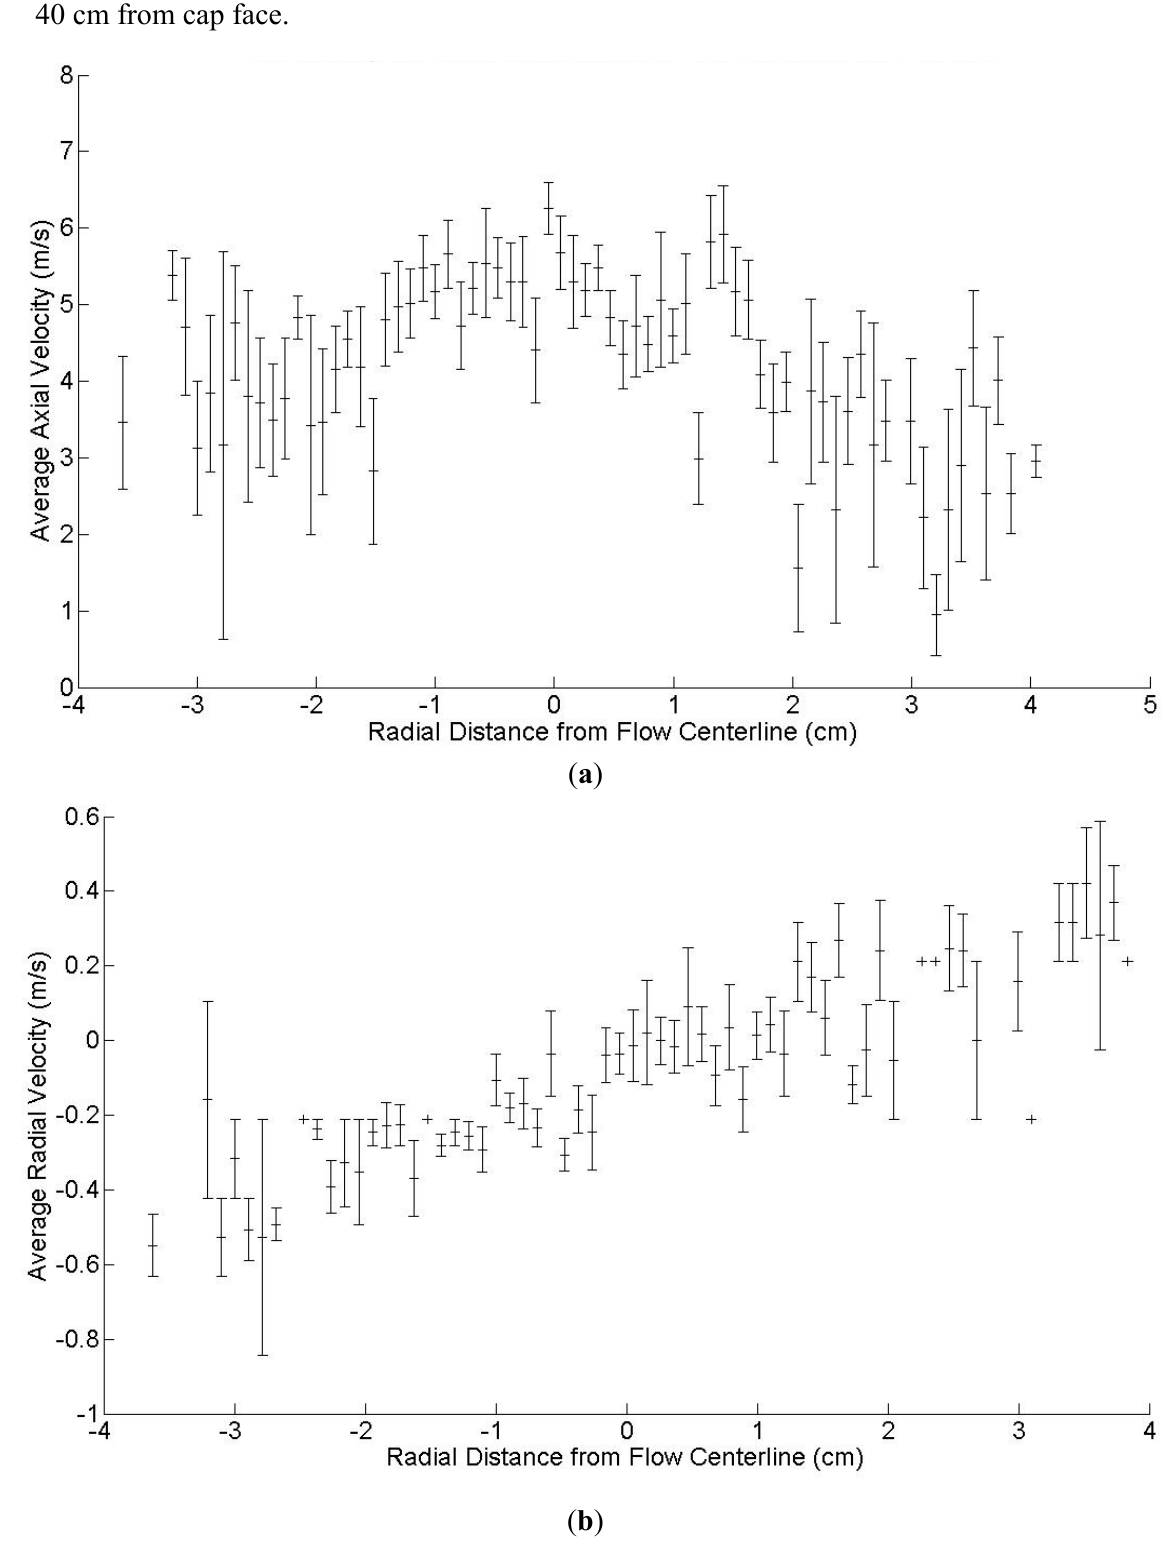
Figure 14. Experiment 3: ( a ) Particle axial velocities and ( b ) particle radial velocities at 40 cm from cap